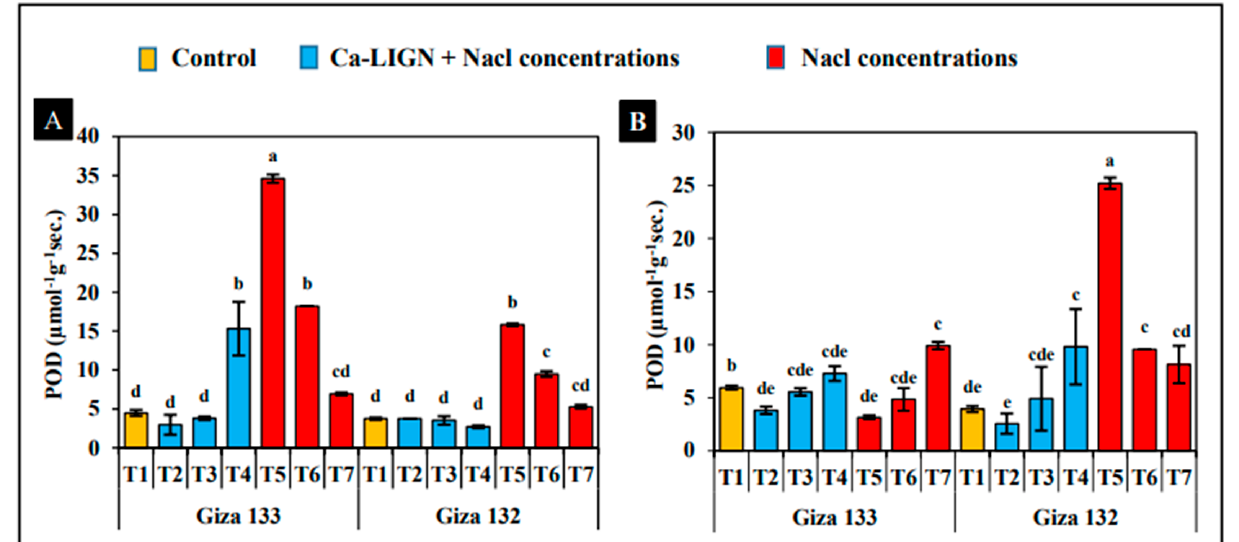
Figure 6. Effect of different treatments: (T1) control, (T2) 100 mM NaCl + Ca-LIGNO, (T3) 200 mM NaCl + Ca- LIGNO, (T4) 300 mM NaCl + Ca-LIGNO, (T5) 100 mM NaCl, (T6) 200 mM NaCl, and (T7) 300 mM NaCl on the average peroxide enzyme activity (POD) in ( A ) leaf and ( B ) root of the two barley cultivars, Giza133 and Giza132, during two seasons, 2019/2020 and 2020/2021. Data represent the mean ± SE (n = 4). The same letter indicates no significant difference ( p ≤ 0.05).